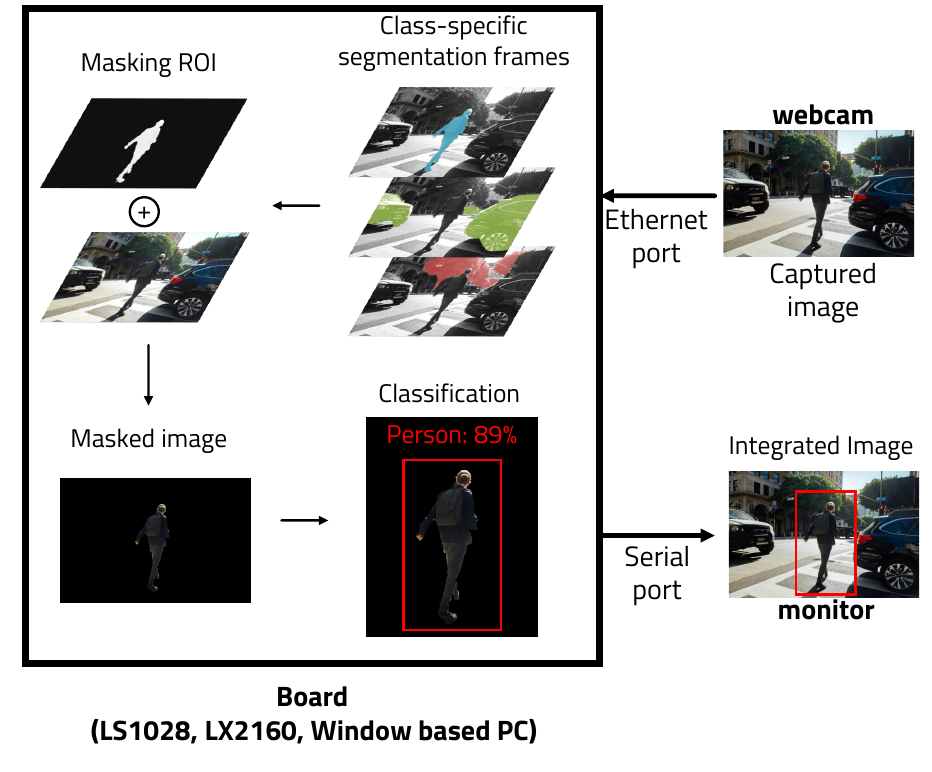
Figure 1. Overall